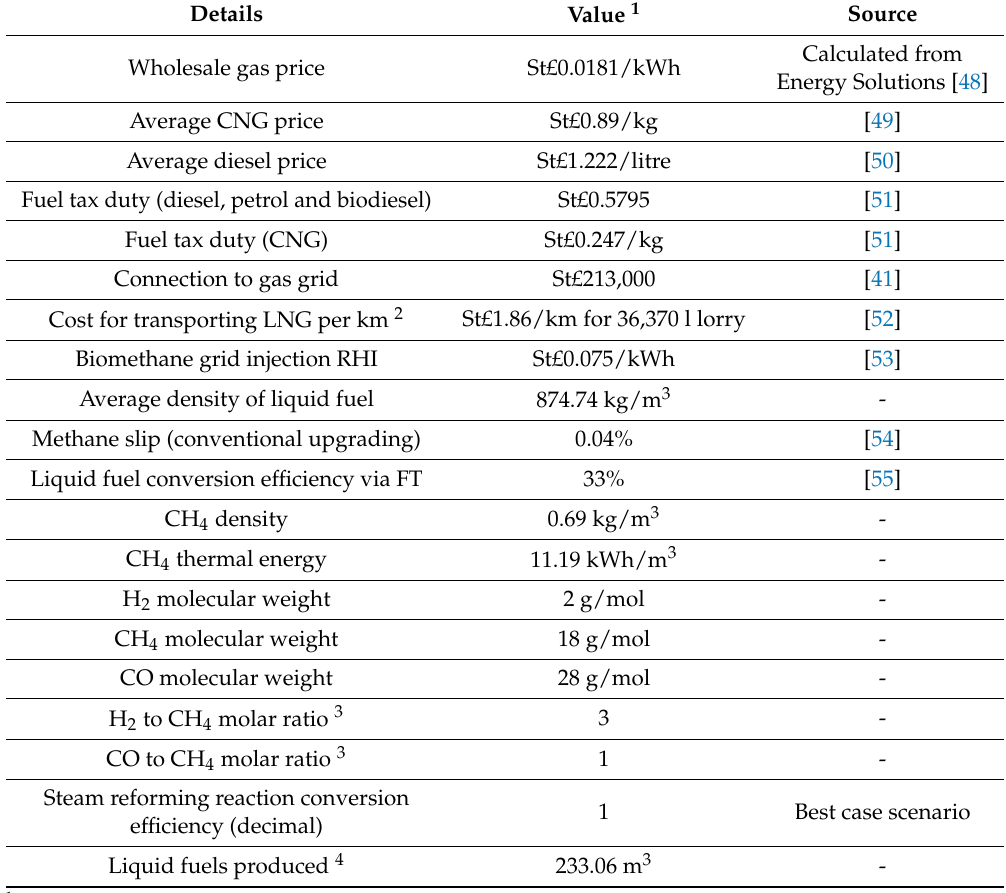
Table 6. Assumptions and prices (UK) used for income